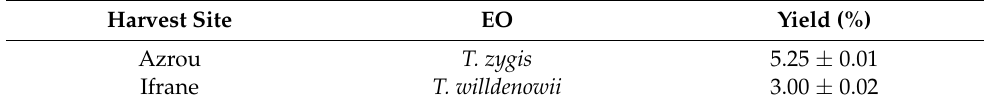
Table 1. The Eos yields of the two selected thyme species.